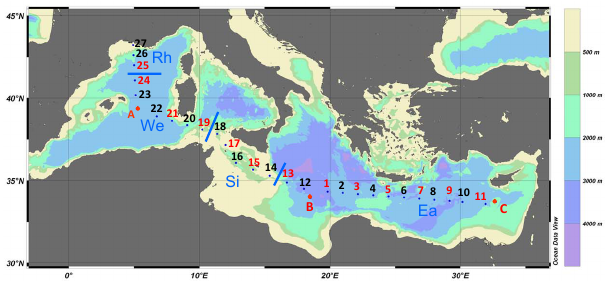
Fig. 1. Map of the BOUM transect. All stations were sampled for bacterial abundances and TChl- a whereas only stations indicated with a code in red were sampled for bacterial production. Blues characters and lines separates the different regions compared (see Material and Method section). Figures 1 and 3 were drawn with Ocean Data View program (Schlitzer,